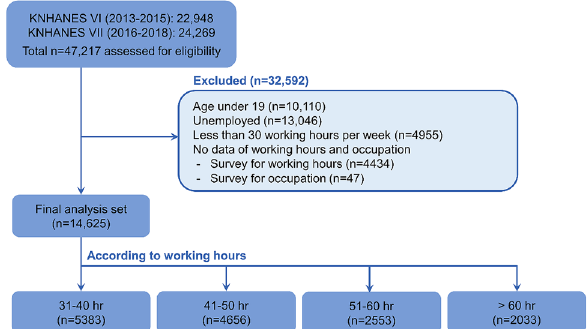
Figure 1. Flow chart of study participants among individuals included in the 2013 to 2018 Korea National Health and Nutrition Examination Surveys (KNHANES VI and